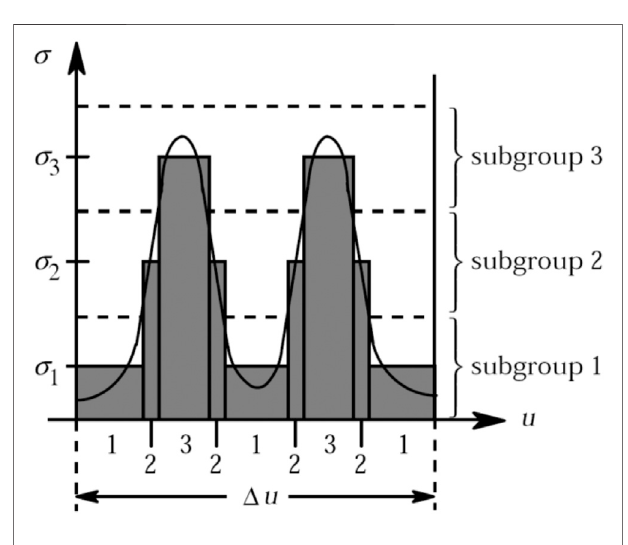
FIGURE 3 | The diagram of subgroup resonance